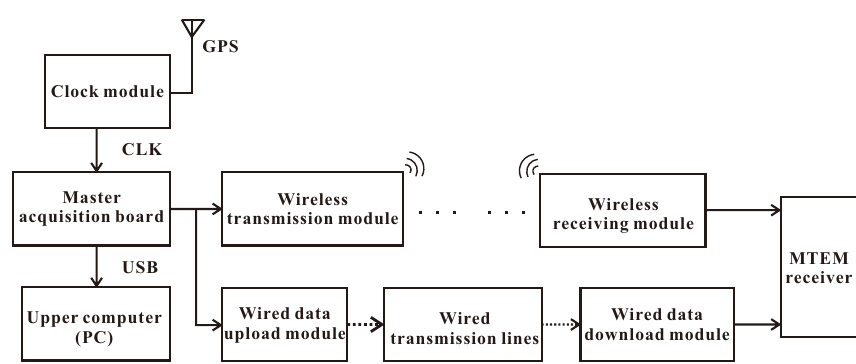
Figure 6. Block diagram of the Bluetooth and 485 module transmission.